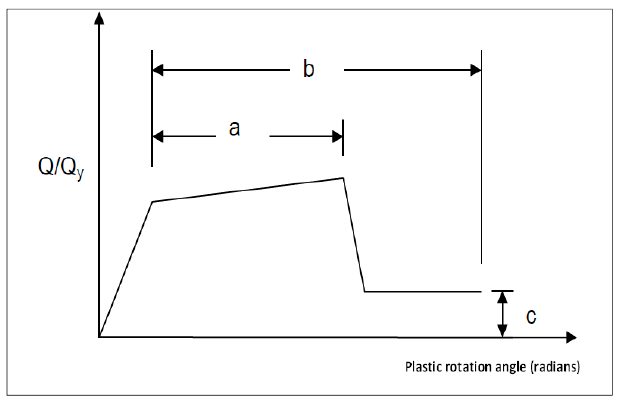
Figure 6. Force-rotation relationship for beam plastic hinges moment resisting frames [1].